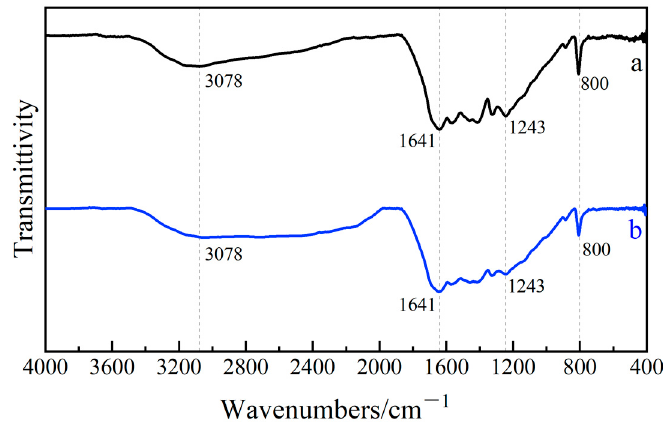
Figure 3. FT ‐ IR spectrograms of g ‐ C 3 N 4 ( a ) and Ag 2 O/g ‐ C 3 N 4 ( b ). Figure 3. FT-IR spectrograms of g-C 3 N 4 ( a ) and Ag 2 O/g-C 3 N 4 ( b